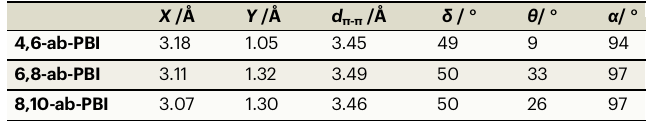
Table 1 | Structural parameters extracted from the crystal structures, as illustrated in Fig.